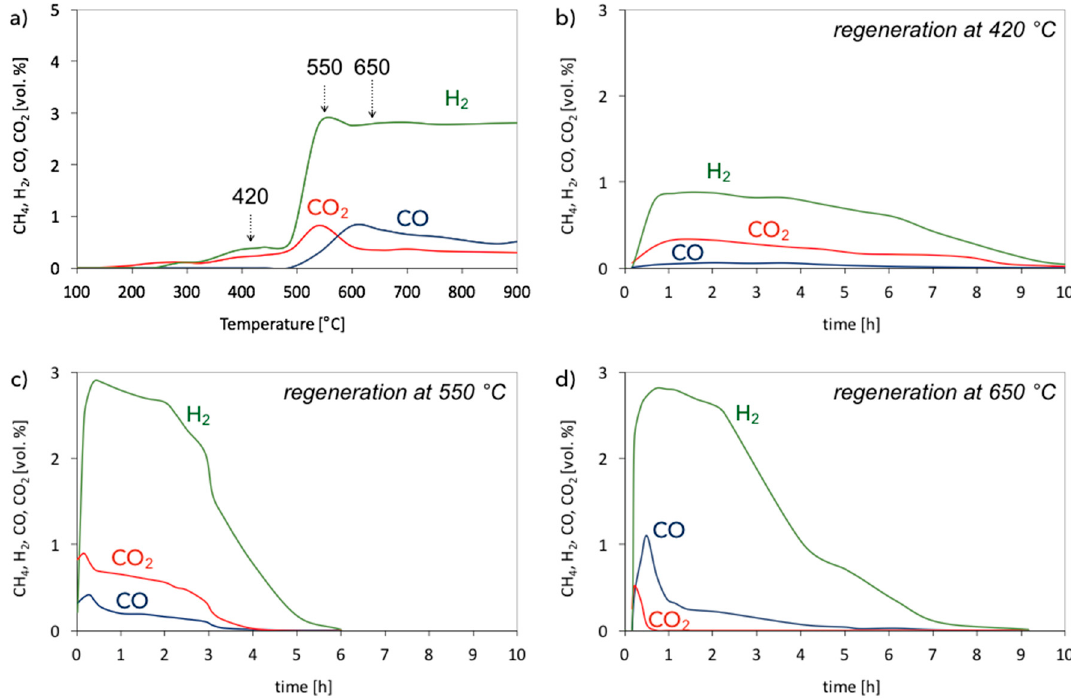
Figure 11. Regeneration of Ni/CeZrO 2 in 2.8 vol.% H 2 O/Ar in ( a ) temperature programmed conditions, and at ( b ) 420 °C, ( c ) 550 °C and ( d ) 650 °C.